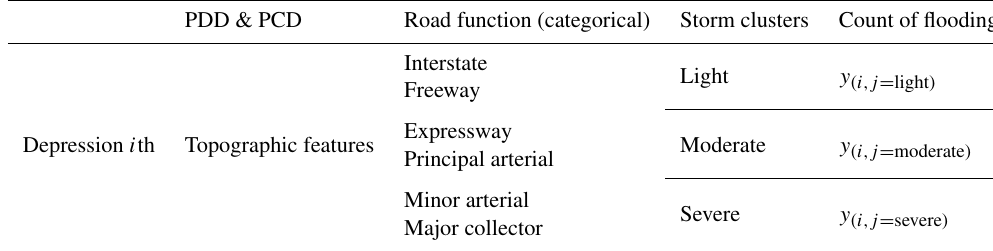
Table 2. Count dataset of PFF